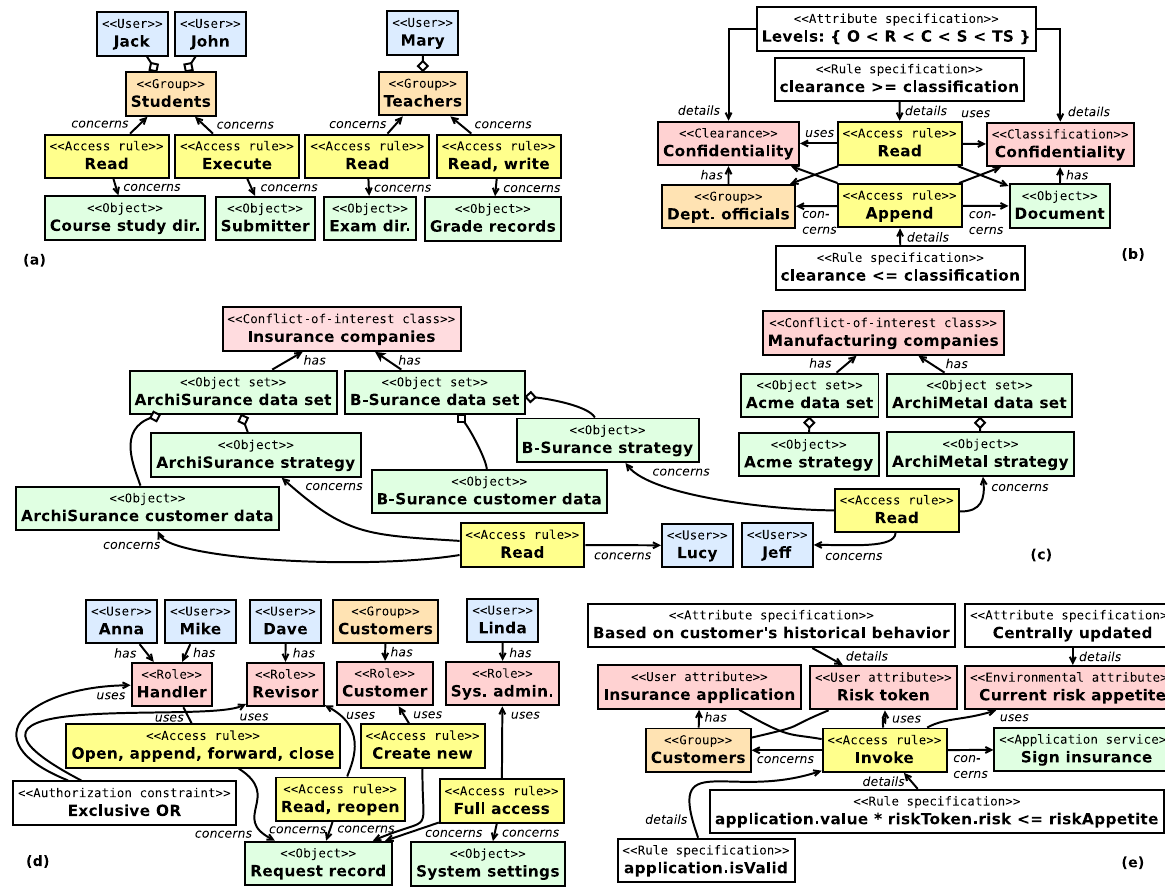
Figure 5. Example scenarios of a (a) DAC; (b) Bell-LaPadula; (c) Brewer-Nash; (d) RBAC; and (e) ABAC/RAdAC/TBAC model configuration. The scenarios are instance models corresponding to the unified metamodel depicted in Figure 4, and each describes a specific access